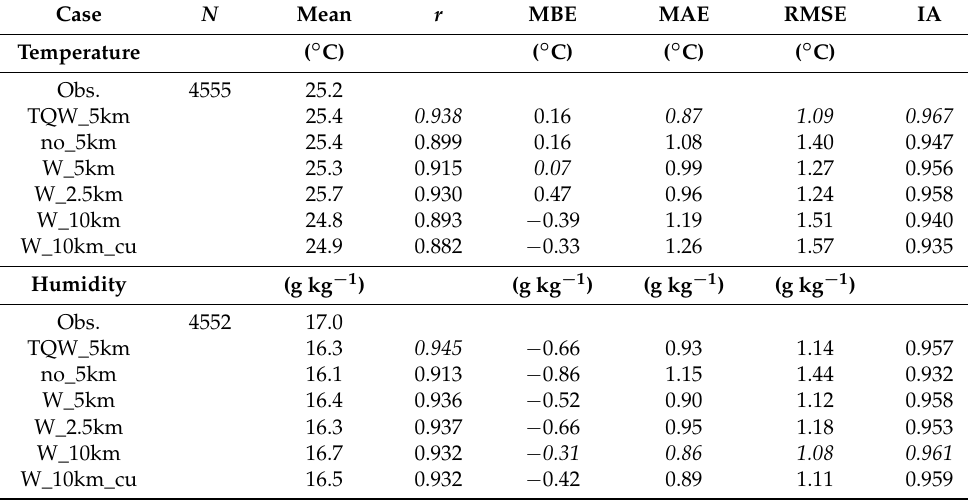
Table 2. Statistical evaluation of WRF performance for simulating daily meteorological variables at meteorological observatories in August